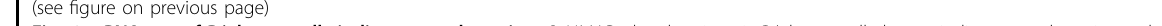
Fig. 6 scRNA-seq of B/plasma cells in liver transplantation. A UMAP plot showing six B/plasma cell clusters in liver transplantation, colored according to different clusters (left panel). Dendrogram of six clusters by hierarchical clustering analysis based on their normalized mean expression values (right panel). B Violin plots showing the normalized expression of MS4A1 , SDC1 , and TCL1A genes ( y -axis) for B/plasma cell clusters ( x -axis). C Gene Ontology enrichment analysis results of B/plasma cell clusters. Only the top 20 most signi fi cant GO terms ( p value < 0.05) are shown in rows. D Cell ratio of different B/plasma cell clusters in PP, EP, and PR samples. GSVA showing the pathways (PID gene sets) with signi fi cantly different activation in different samples of B/plasma cell clusters. Different colors represent different activation scores. E Number of down-regulated DEGs between different samples in different B/plasma cell clusters. F Gene Ontology enrichment analysis results of downregulated DEGs from PR vs. PP. Only the top 20 most signi fi cant GO terms ( p value < 0.05) are shown in rows. G GSVA showing the pathways (HALLMARK gene sets) with signi fi cantly different activation in different samples of B/plasma cell clusters. Different colors represent different activation scores. H Cell – cell interaction analysis between mononuclear phagocyte clusters and different B/plasma cell clusters in PR samples. Ligand-receptor pairs labeled in y - axis. The size of the circle represents the level of p value, and different colors represent different means values. Ligands come from mononuclear phagocyte clusters, and receptors come from B/plasma cell